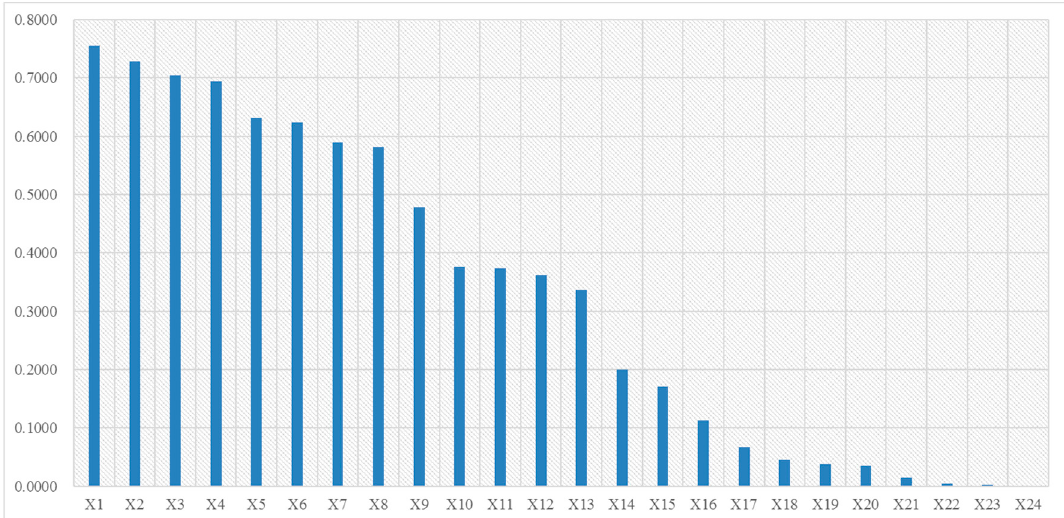
Figure 2. Explanatory power of influencing factors on population density.